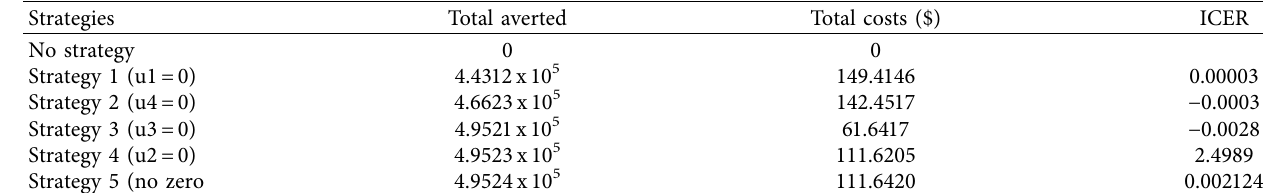
Table 2: Rank of strategies based on the number of the infection averted.